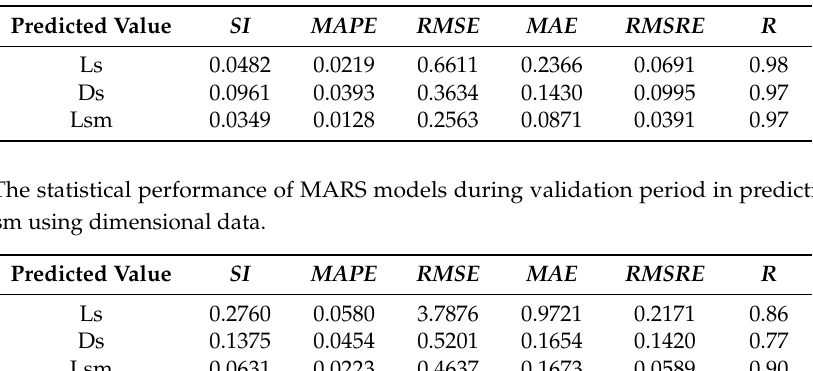
Table 2. The statistical performance of ELM models during validation period in prediction of Ls, Ds and Lsm using dimensional data.